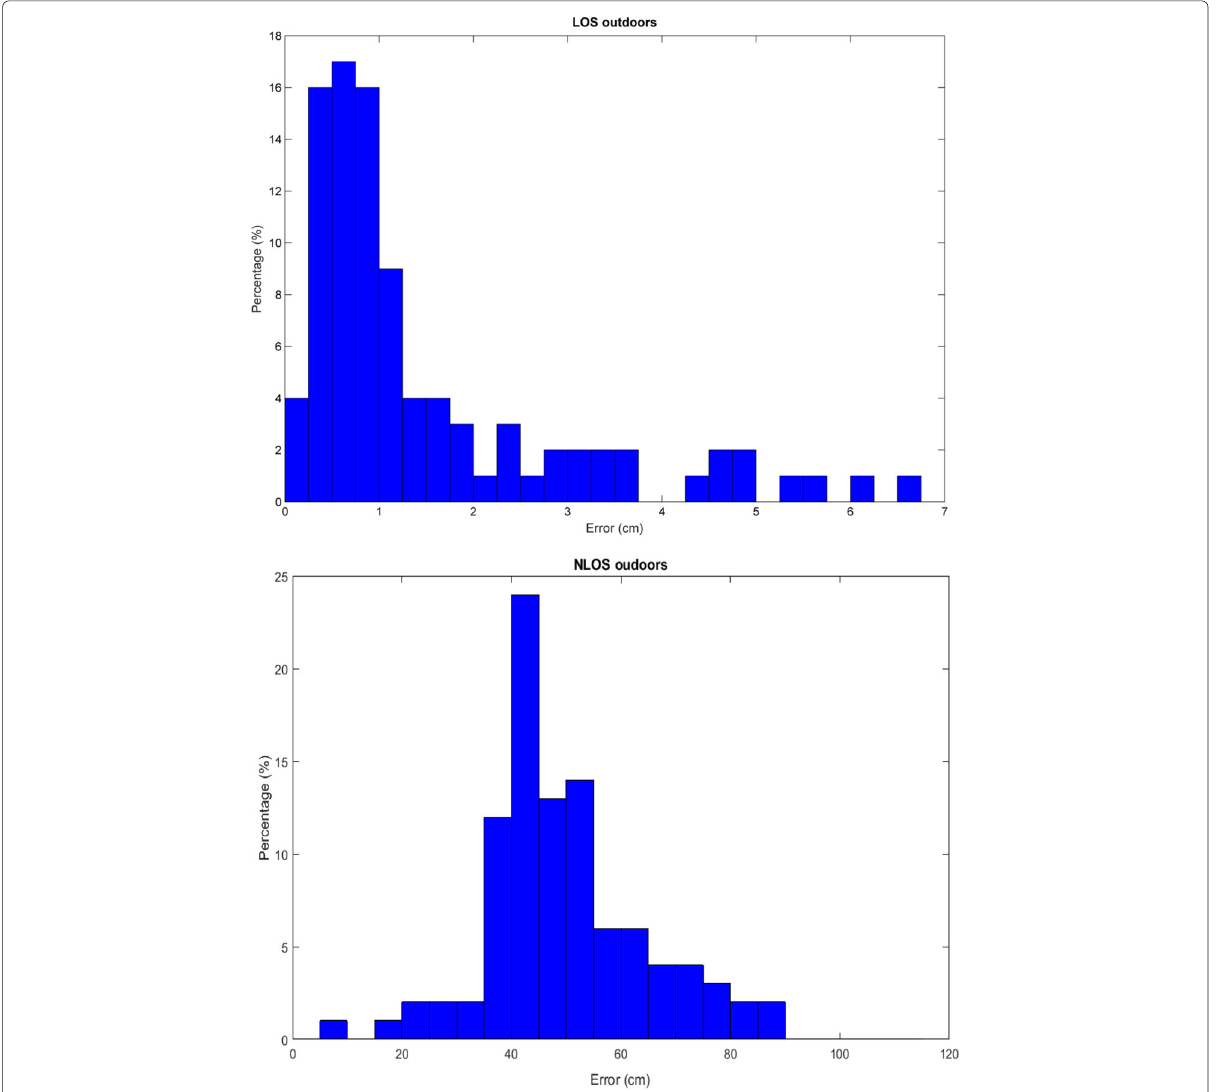
Fig. 14 Algorithm simulations for LOS and NLOS outdoor UWB channel model. This figure represents the repartition depending on the error between the blind UE position and the estimated position for LOS and NLOS outdoor. These results are obtained after 100 simulations. The simulation results show that the localization accuracy in LOS environments has an estimation error below 2 cm in 73% of the cases and below 55 cm in 71% of the case in NLOS